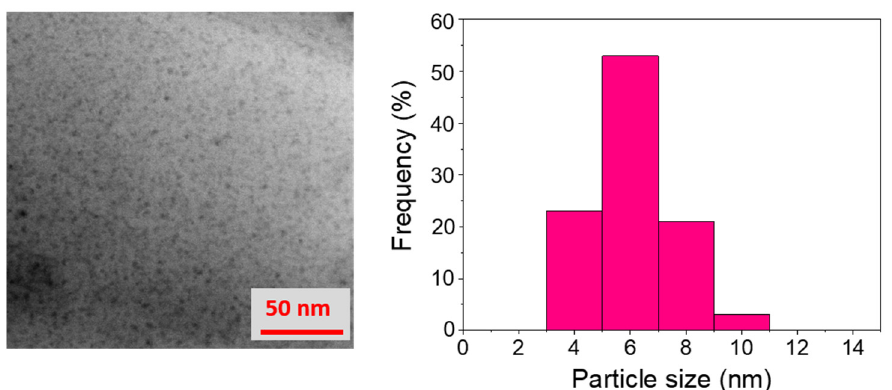
Figure 9. Transmission electron microscopy (TEM) image and NPs size distribution of spent 6 wt.% Co/CNR115. 6 wt.%